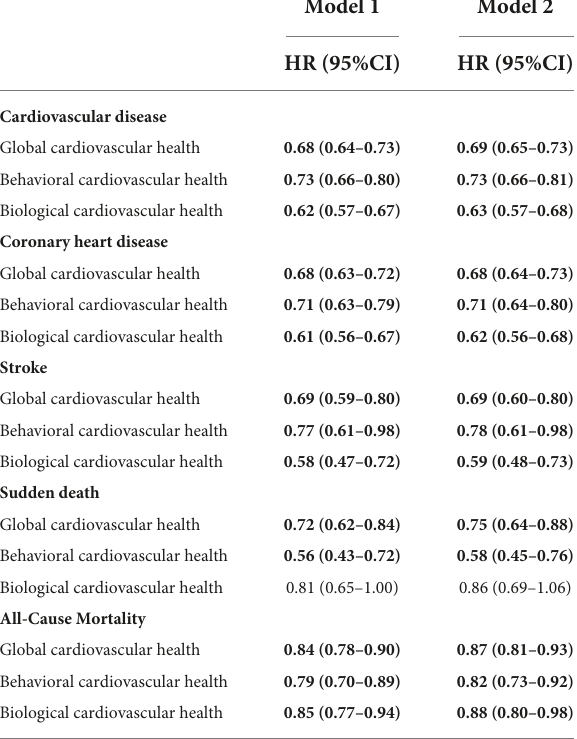
TABLE 3 Cox proportional hazard model for different cardiovascular events, and all-cause mortality (per one additional metric): Tehran Lipid and Glucose Study (TLGS), 2005–2018.